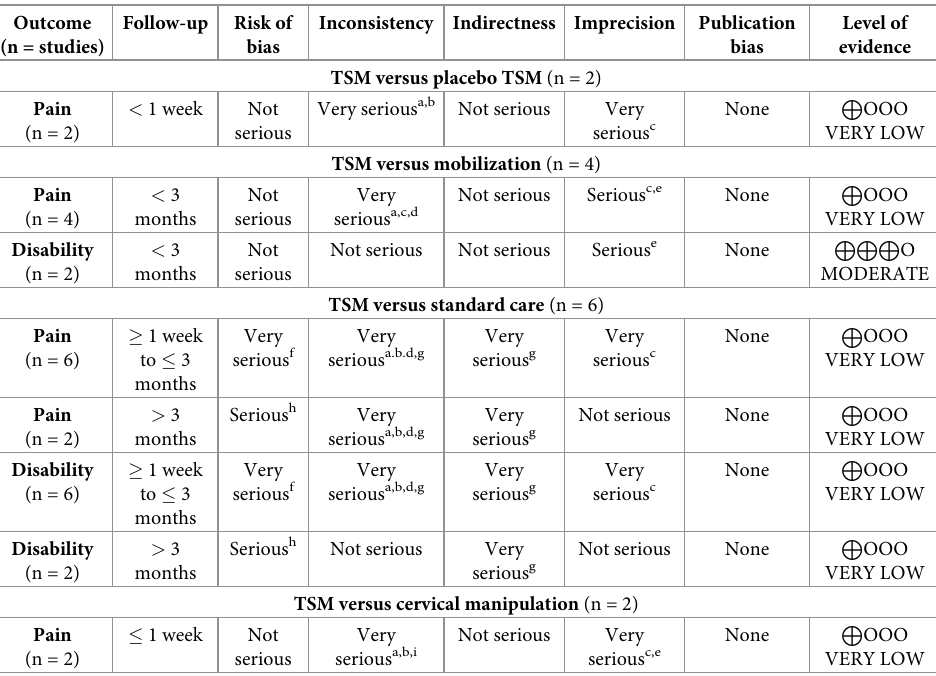
Table 6. GRADE evidence